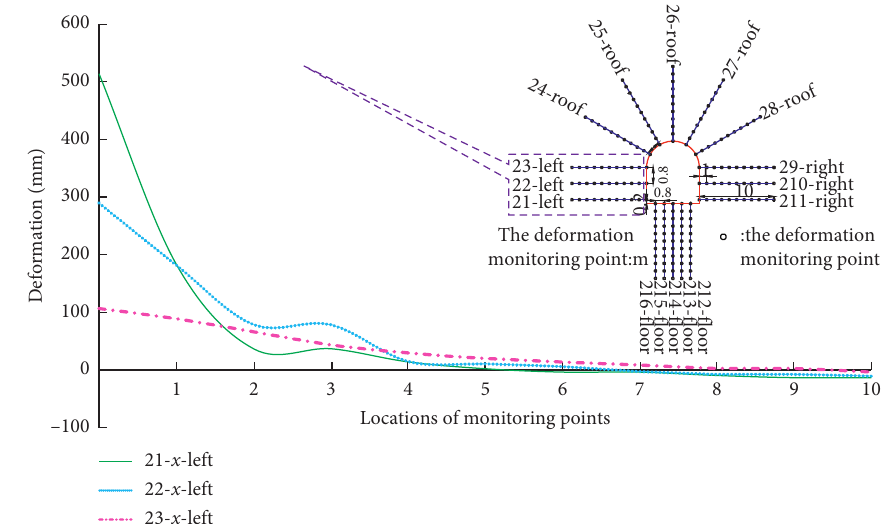
Figure 8: The deformation law of the surrounding rock of roadway